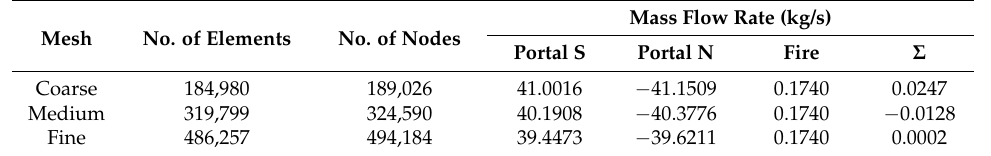
Table 3. Preliminary test meshes and the overview mass flow rate balances.